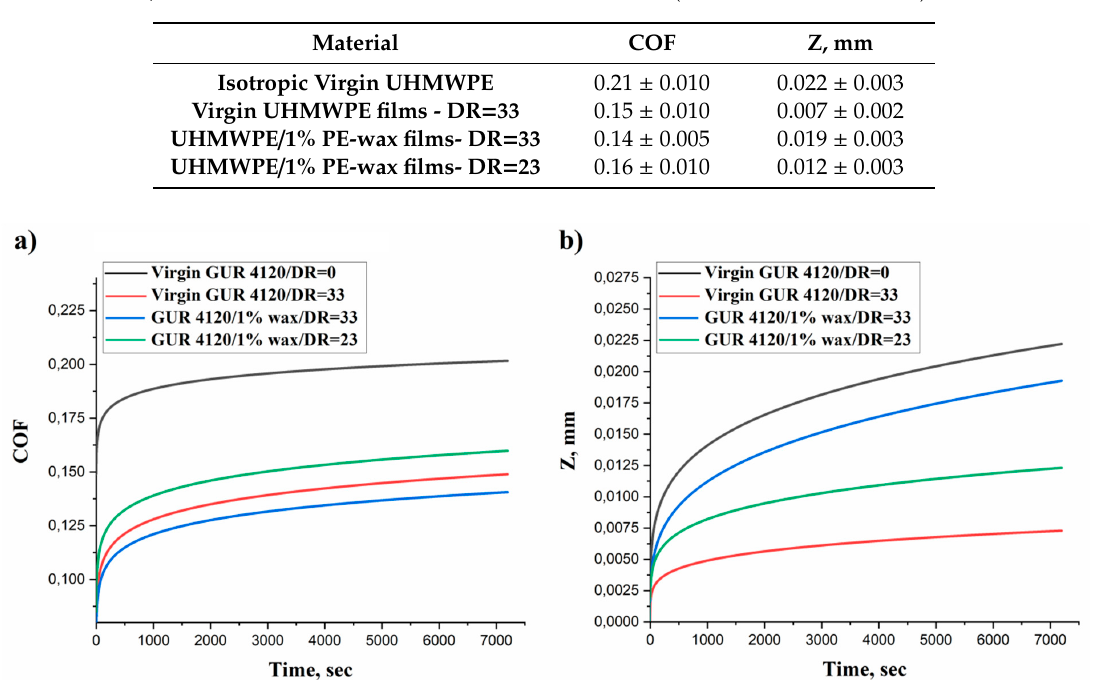
Table 5. Tribological properties of isotropic UHMWPE and virgin UHMWPE film in comparison with